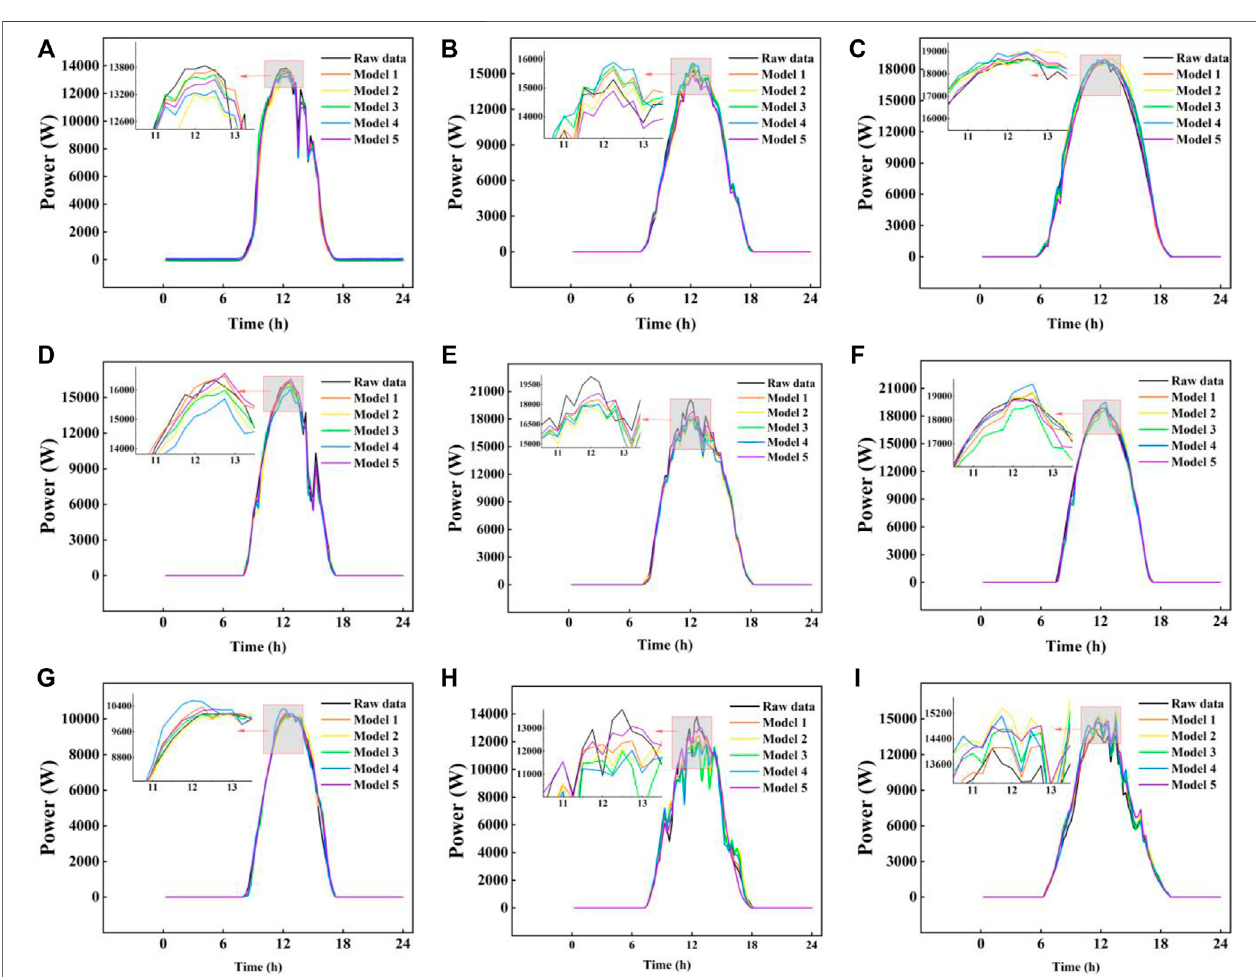
FIGURE 6 | The corresponding prediction results of each model on different tasks. Speci fi cally, (A – I) show the prediction results of prediction tasks 1 to 9, respectively. Models 1 to 5 can achieve good prediction results in different prediction tasks.